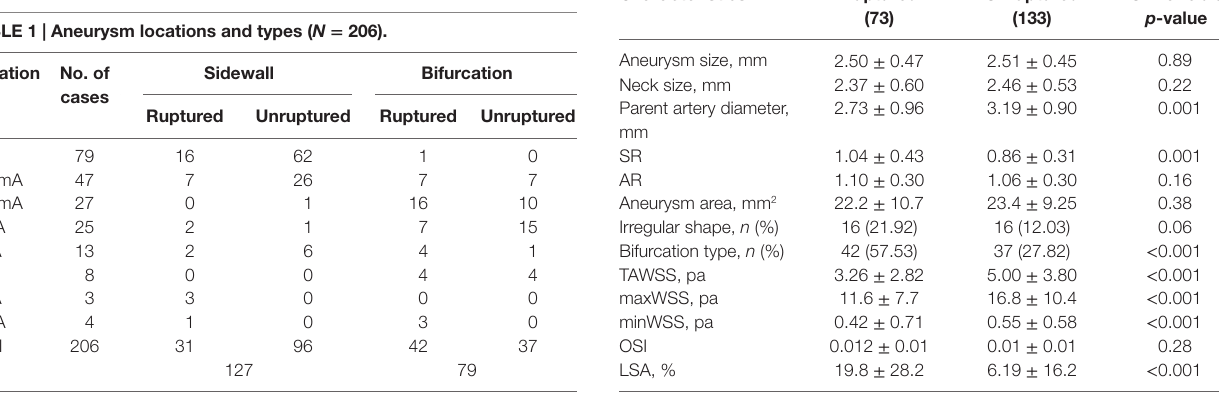
TaBle 2 | Differences in morphologic and hemodynamic measurements between ruptured and unruptured Vsias.